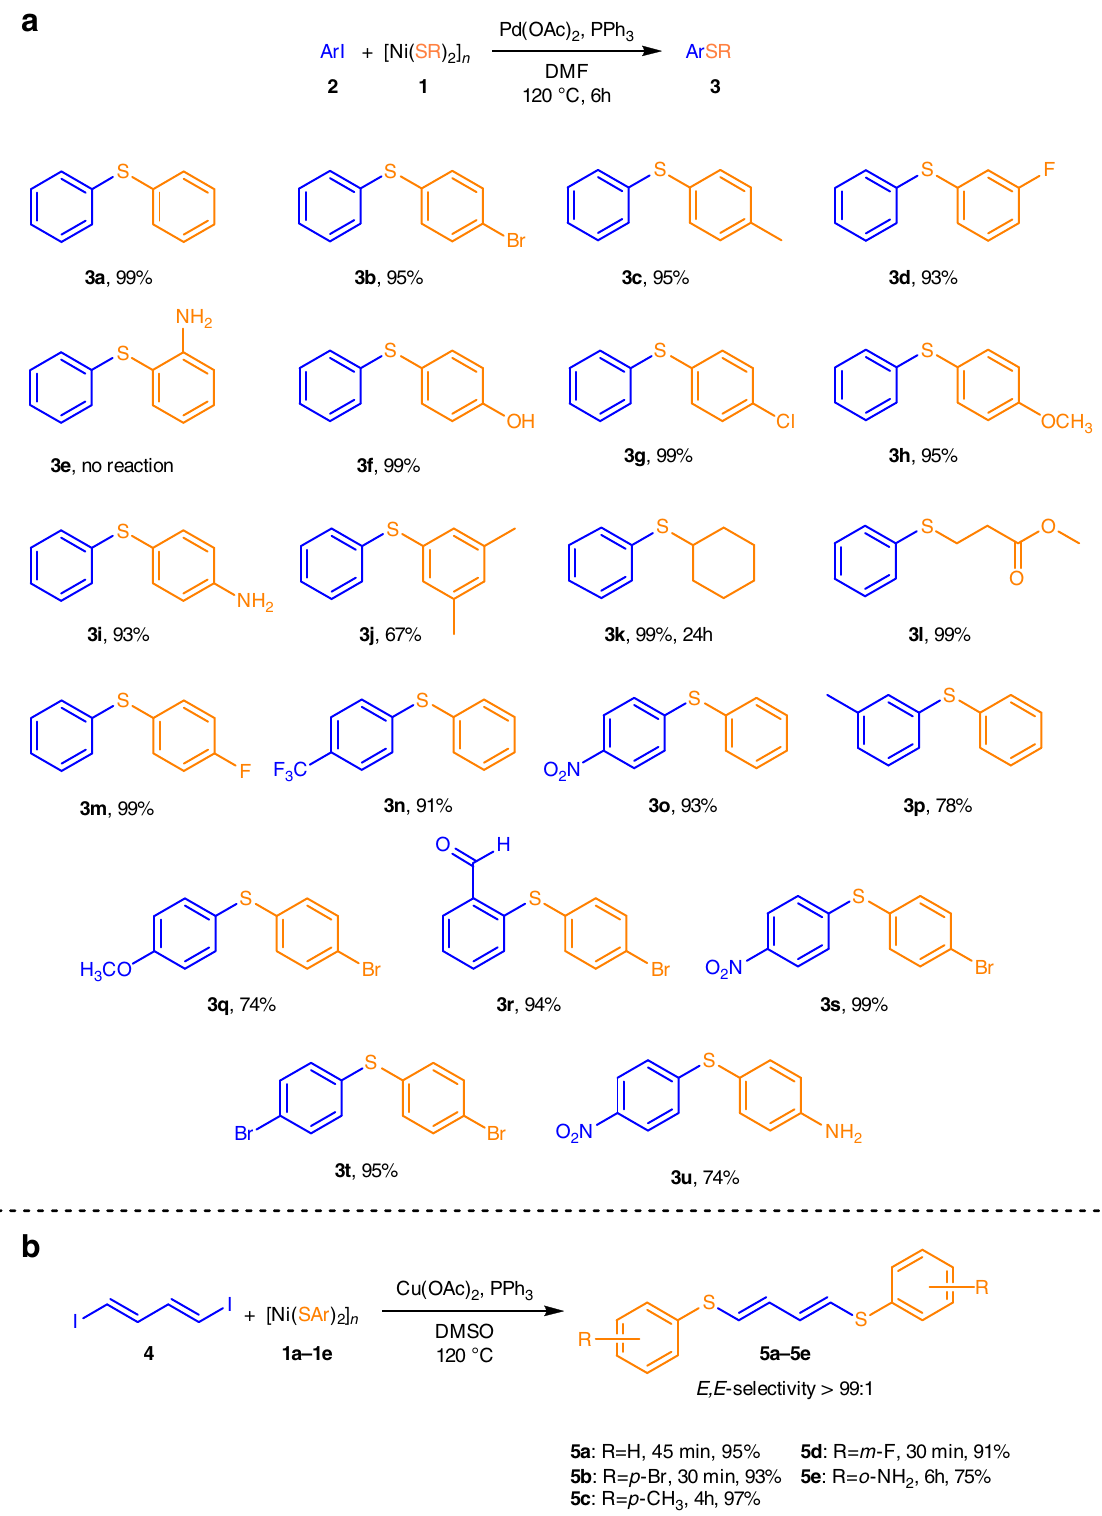
Fig. 9 C – S cross-coupling reactions with nickel thiolates. Palladium-catalyzed C – S bond formation reaction between various aryl iodides and nickel thiolates ( a ). Copper-catalyzed C – S cross-coupling with ( E , E ) − 1,4-diiodobuta-1,3-diene ( b ). See Supplementary Methods for experimental